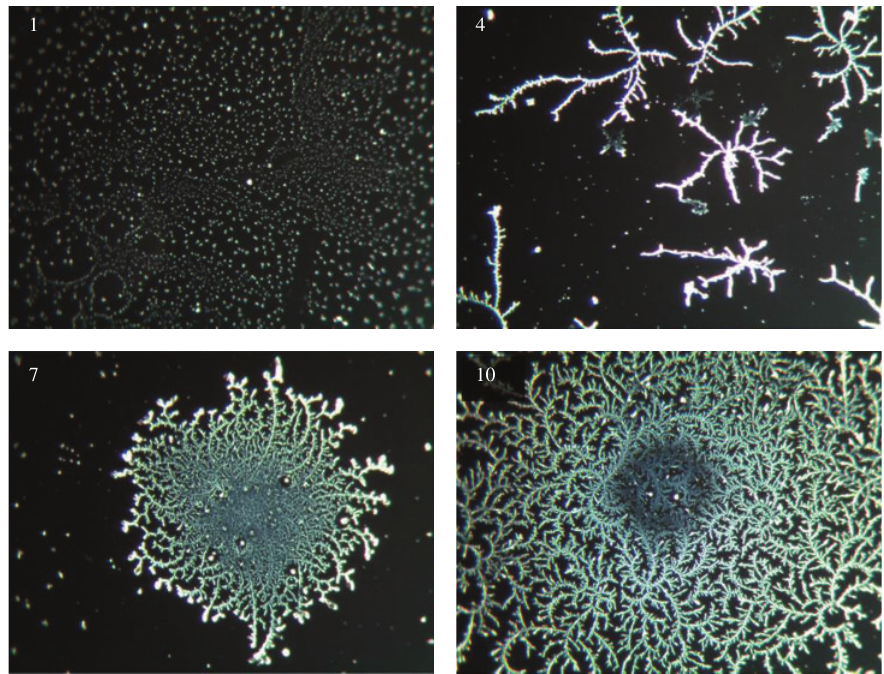
FIGURE 2: Reference pictures for visual evaluation with indication of scores (1, 4, 7, and 10), magnification